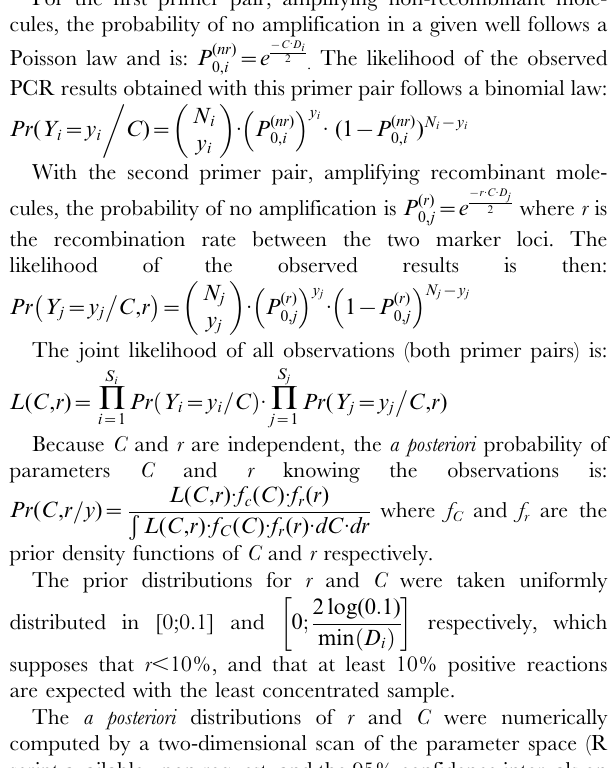
Figure S1 Polymorphisms at 14a in various F1. A. Localization of polymorphisms between the Col and the L er accessions (black diamond), the Col and the Ws-4 accession (purple triangle), the Col and the Pyl-1 accession (green dot). The numbers on the left refer to the percentage of polymorphisms between Col and the other accessions. B. CO distribution at 14 a in various F1s. (PPT) Figure S2 Cumulative CO rates at 14a in ColxL er and ‘‘MSH4.’’ For both reciprocal orientations, cumulated (from left to right) relative CO rates were scored at successive polymorphic sites along the region. Blue curves: cumulated relative ‘CtoL’ CO rates; dark blue: ‘‘MSH4’’; light blue: ColxL er . Red curves: cumulated relative ‘LtoC’ CO rates; dark red: ‘‘MSH4’’; light red: ColxL er . Vertical lines: median positions of the hotspots; dotted: ‘‘MSH4’’; filled: ColxL er . (PPT) Figure S3 NCO at 130 6 in ‘‘MSH4’’ and Atmsh4 2 / 2 . . Position of SNPs genotyped are indicated by green filled circles (SNPs) or triangles (indel). The polymorphisms are indicated by filled